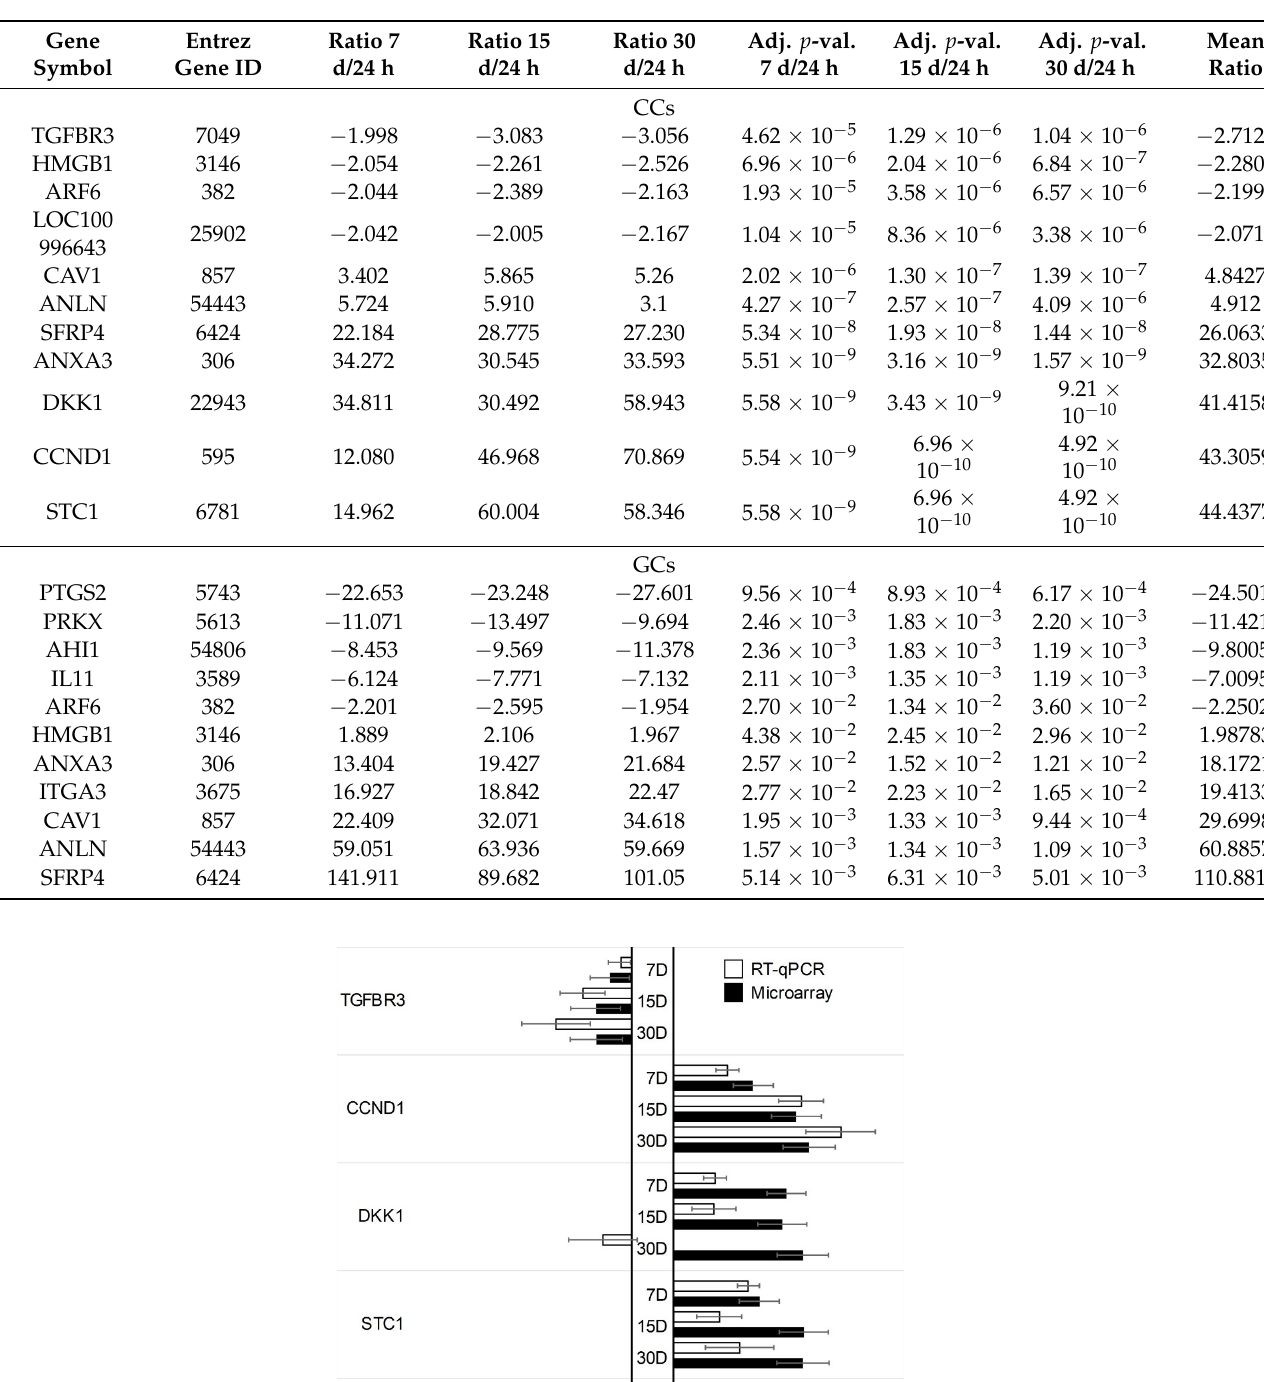
Table 2. Fold change in expression ratio, Entrez gene IDs, corrected p -values, and mean values of the fold change ratio of the 15 selected genes expressed in CCs and GCs.